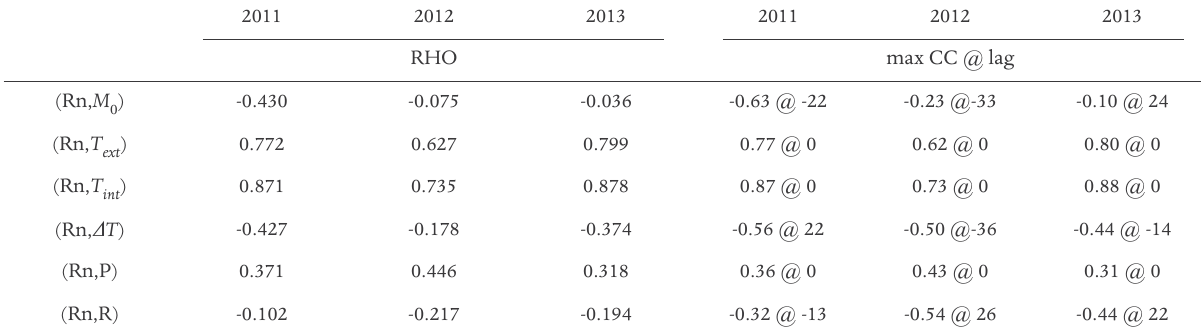
Table 2. Annual value of Pearson’s correlation coefficient (RHO) and maximum value of Cross-Correlation (max CC) with its respective lag between the 15-days moving average of radon concentration (Rn) and the 15-days moving average of each one of other variables